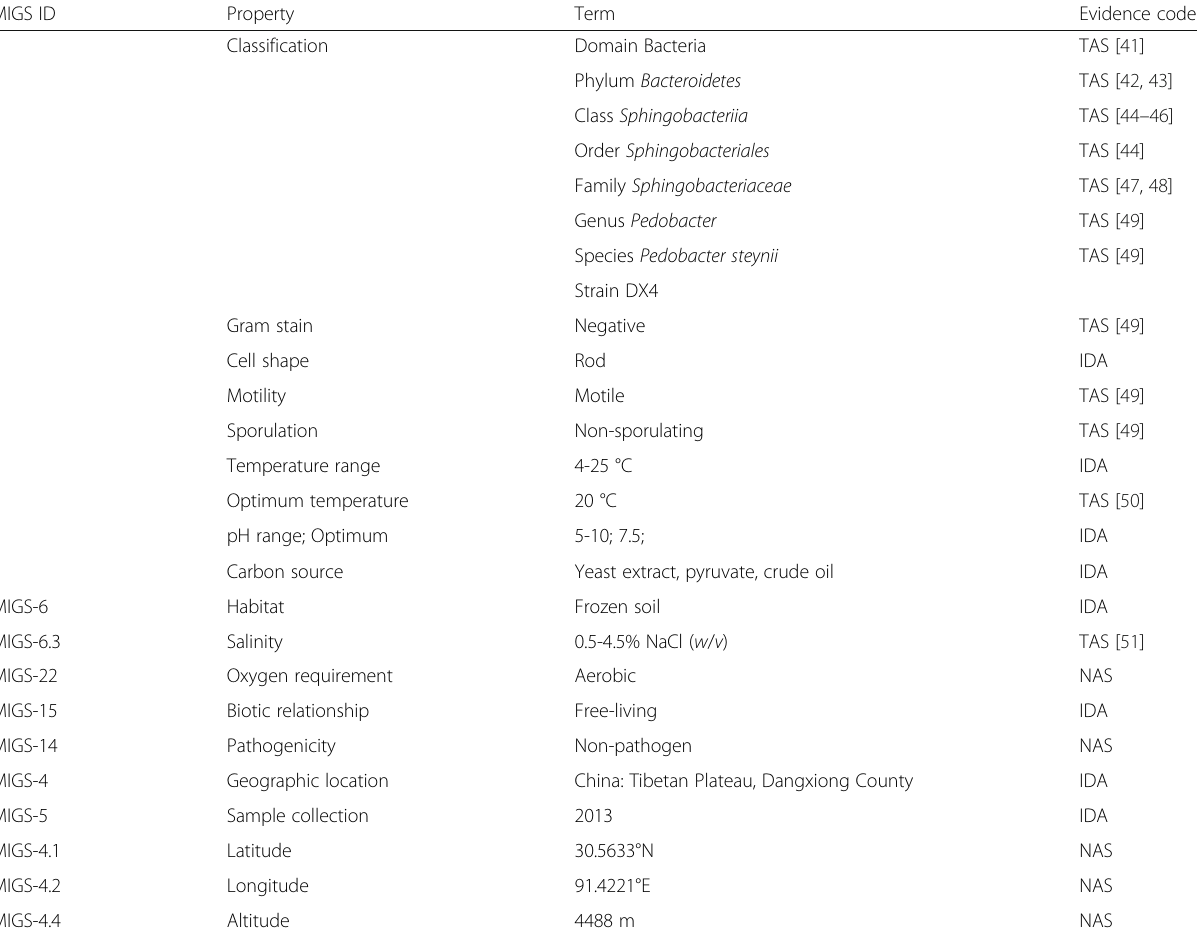
Table 1 Classification and general features of Pedobacter steynii DX4 MIGS